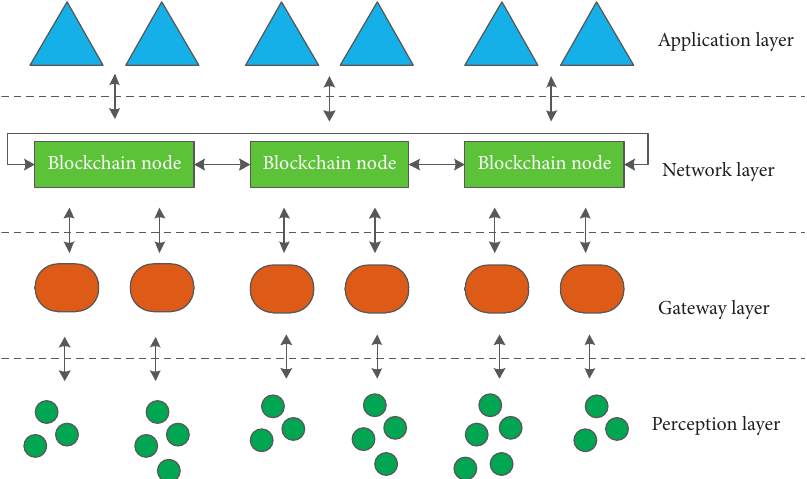
Figure 1: System model of IoT based on blockchain.